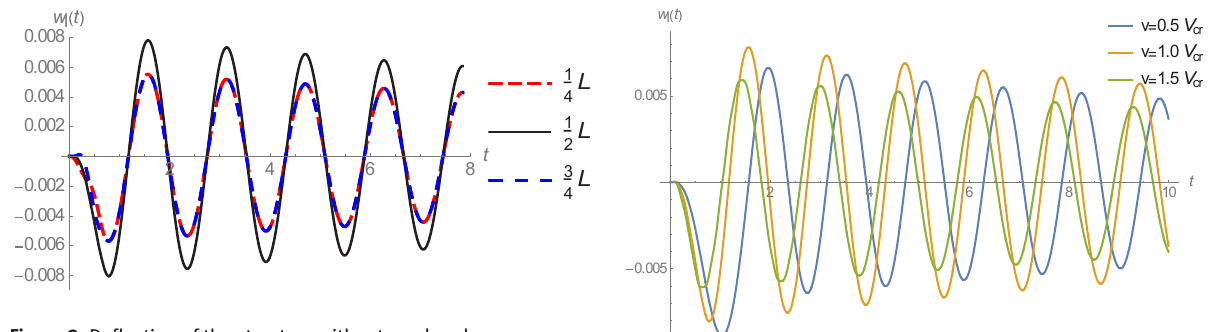
Figure 3: Deflection of the structure without an absorber.